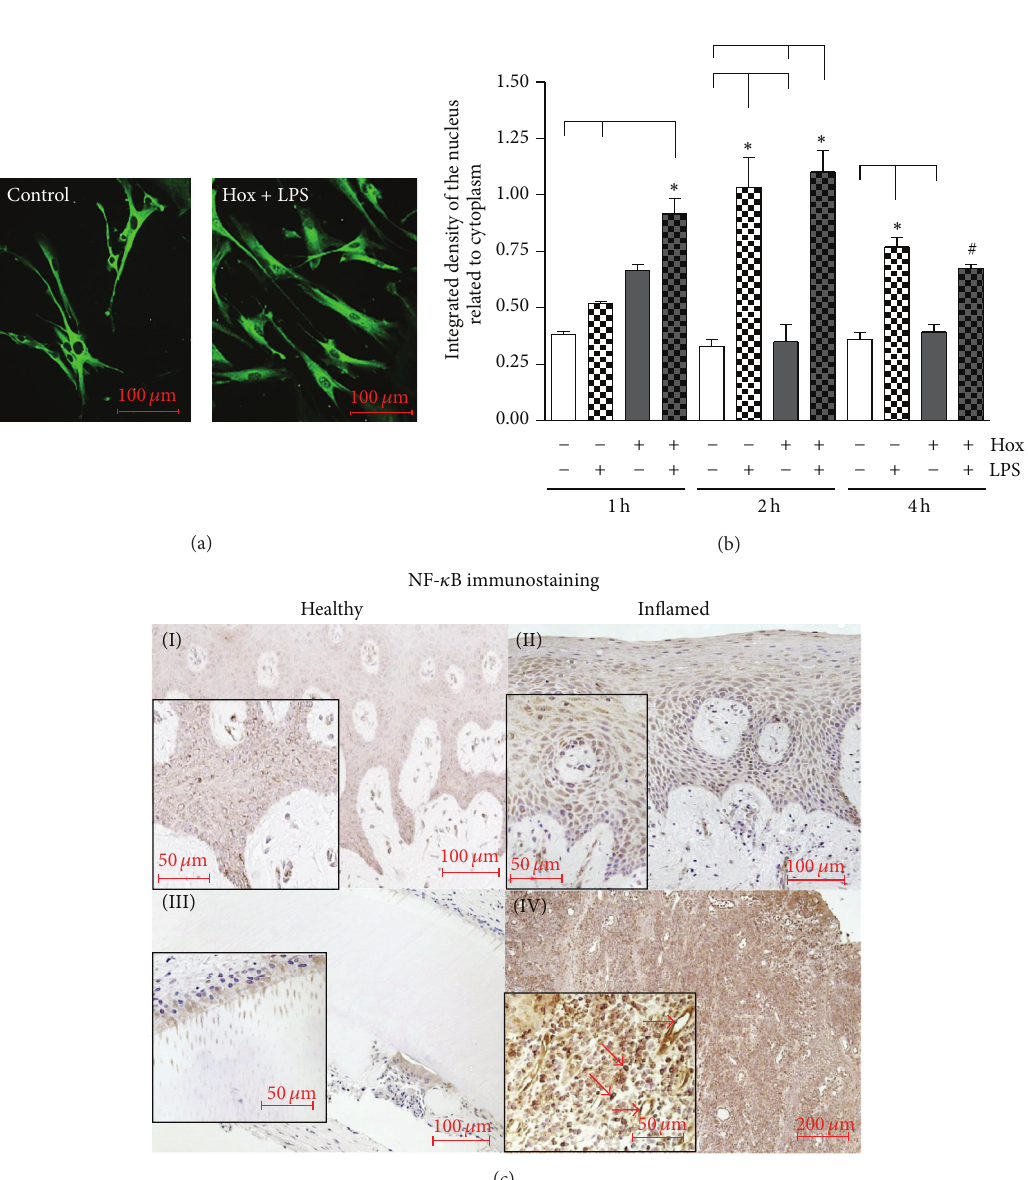
Figure 3: Activation of NF- 𝜅 B . (a) NF- 𝜅 B was visualized by immunofluorescence staining. PDL cells were cultured under normoxic (control) orhypoxiccondition(Hox)andstimulatedwithLPS-PG(1 𝜇 g/mL).NF- 𝜅 Bactivationwasvisibleasenhancednuclearstaining.